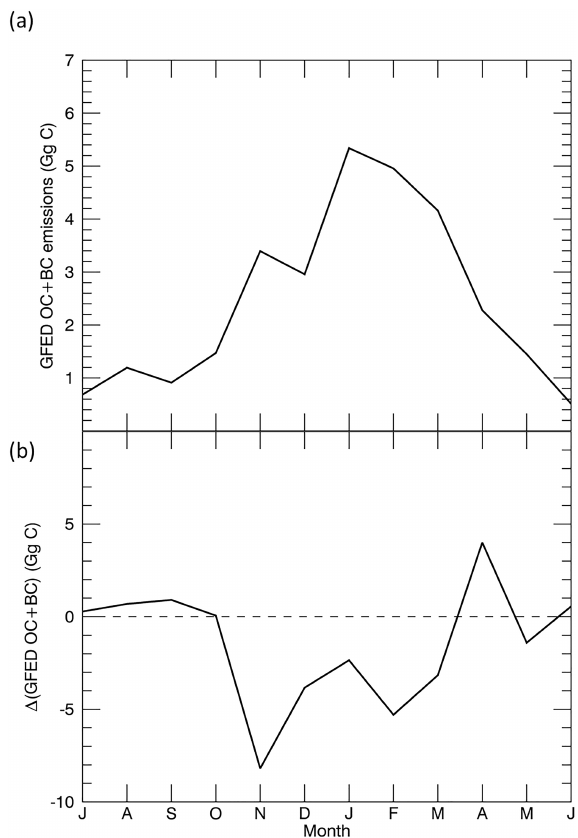
Figure 4. (a) Seasonal variation in organic and black carbon emis- sions from GFED (in GgC) over southern China from 2006 to 2015. (b) Corresponding changes on a monthly basis (in GgC per month) during the same period.